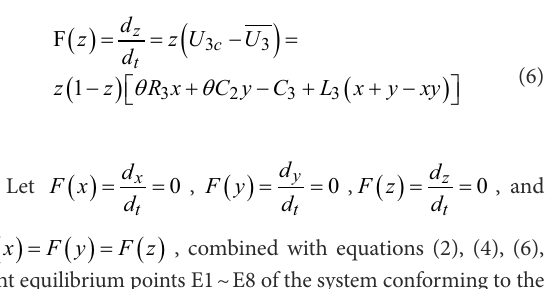
eight equilibrium points E1 ~ E8 of the system conforming to the parameter value range are obtained, as shown in Table 3.